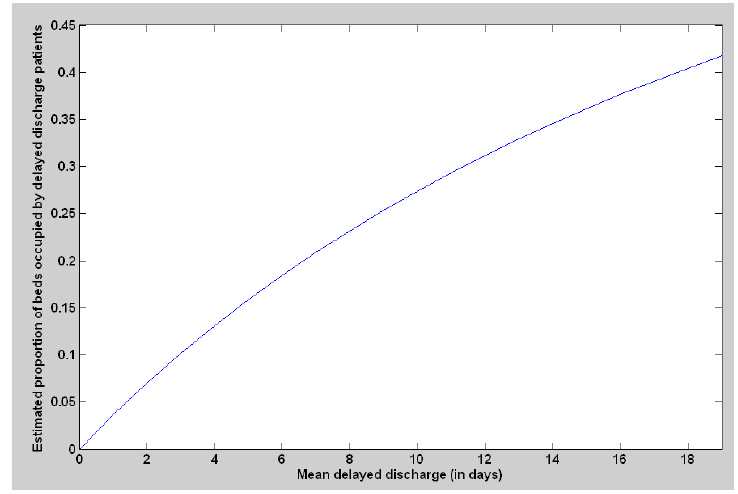
Figure 11. The estimated proportion of beds occupied by delayed discharge patients (after 1000 days since the first patient gets delayed).